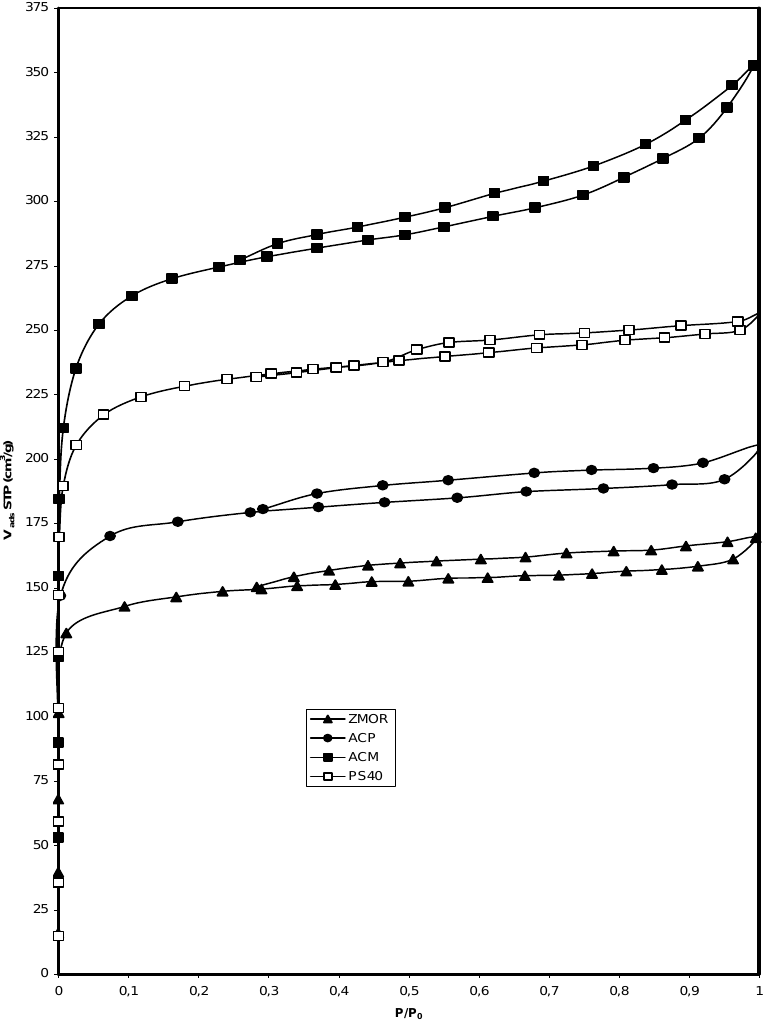
Figure 1. N Adsorption isotherms at 77 K of the porous solids used in this 2